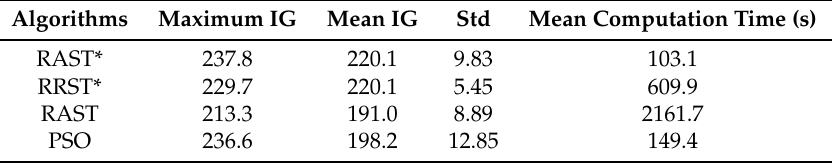
Table 2. Performance comparison of RAST*, RRST*, RAST, and PSO for Scenario 2.